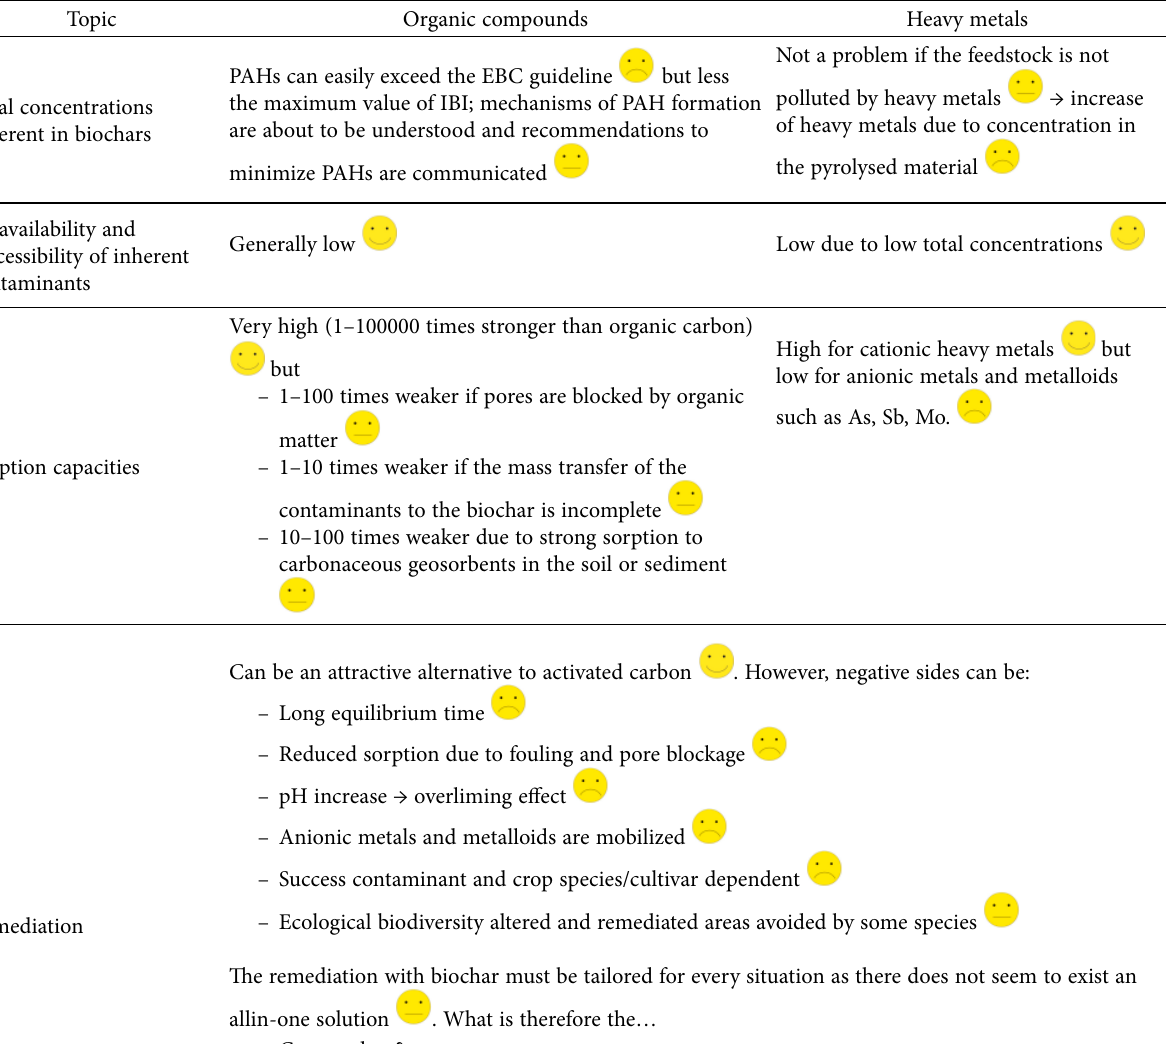
Table 3. Qualitative overall assessment of contaminant-related aspects of biochar, of biochar itself, and its suitability for remediation of contaminated sites. Emoticons indicate whether the outcome per topic is positive, negative or